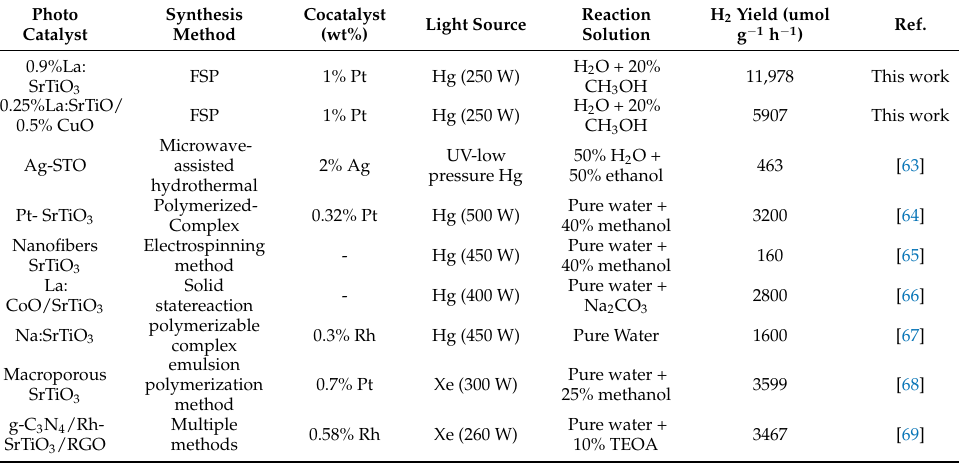
Table 2. Hydrogen production rates and conditions reported for similar